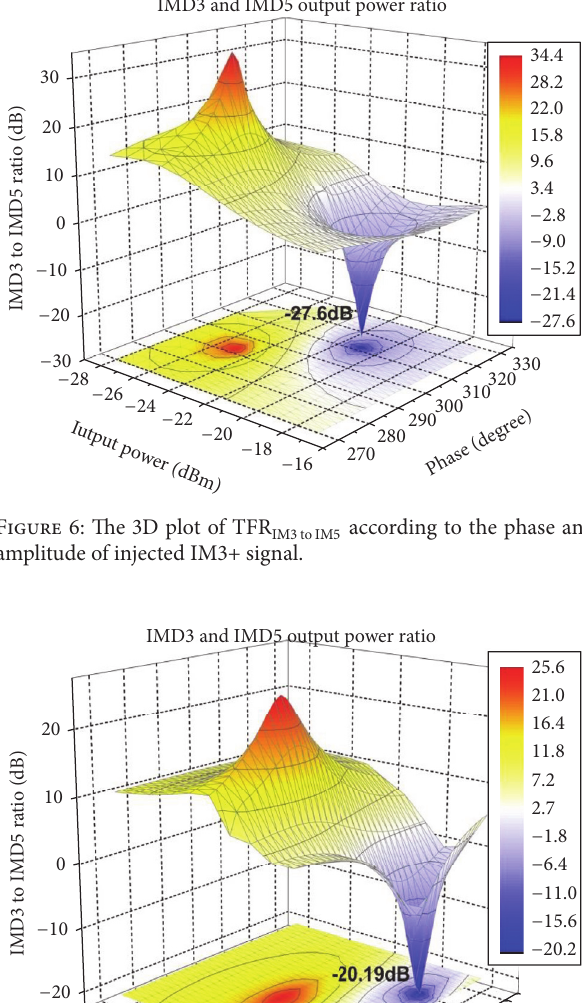
Figure 7: The 3D plot of TFR IM 3 amplitude of injected 2HD.